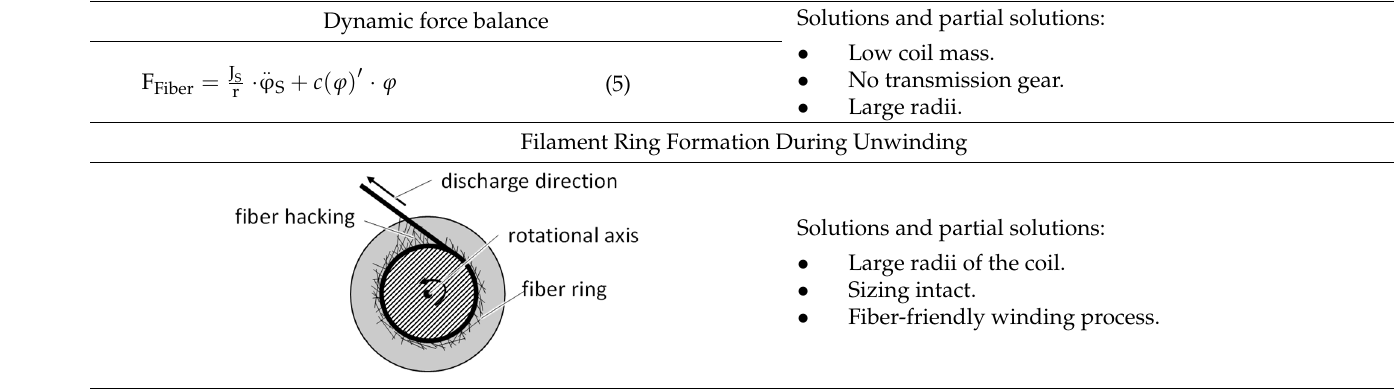
Table 1. Cont. Yarn Damage Due to Mass Inertia, Bearing and Gear-Related Frictional Resistance Dynamic force